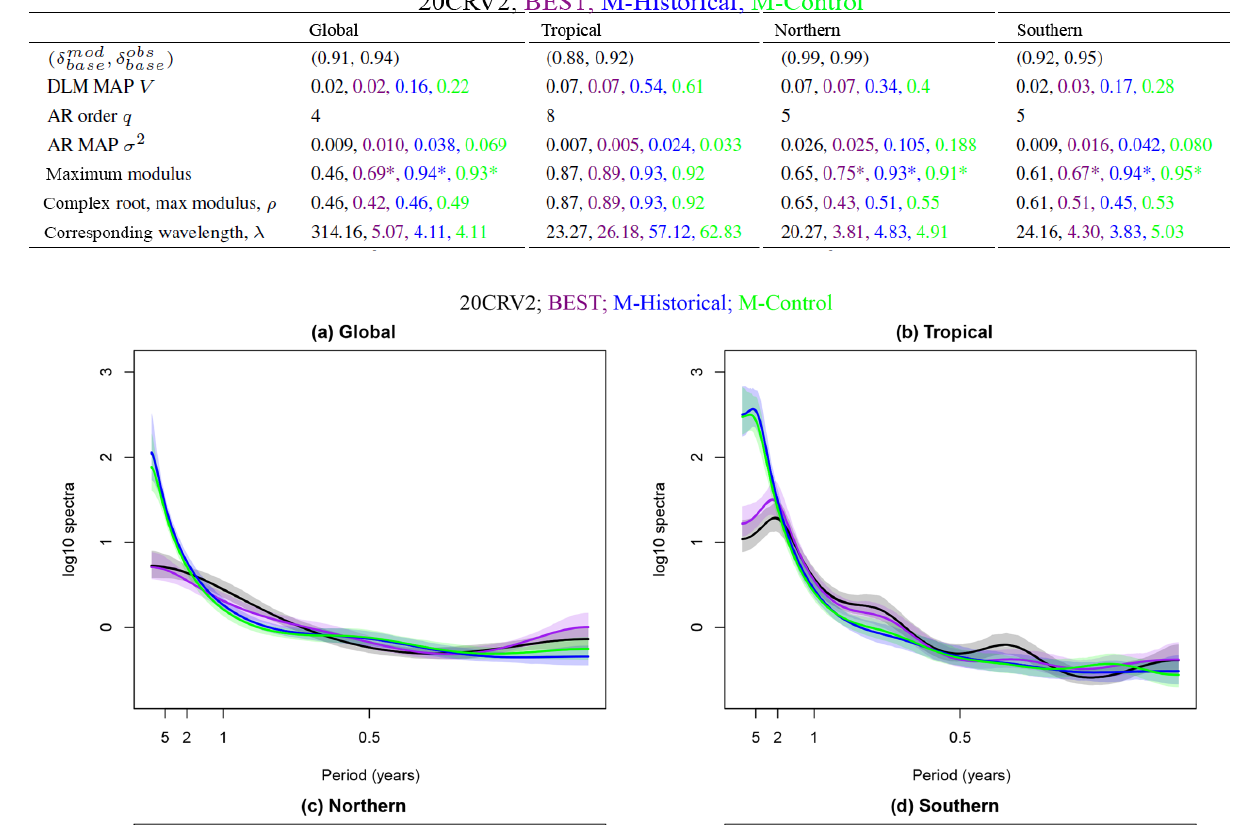
distinctly higher. In the Northern Hemisphere the two obser- vational products are indistinguishable. In general, the model versus observation differences in amplitude are less clear, al- though pronounced differences are seen in the annual cycle of the globe and Northern